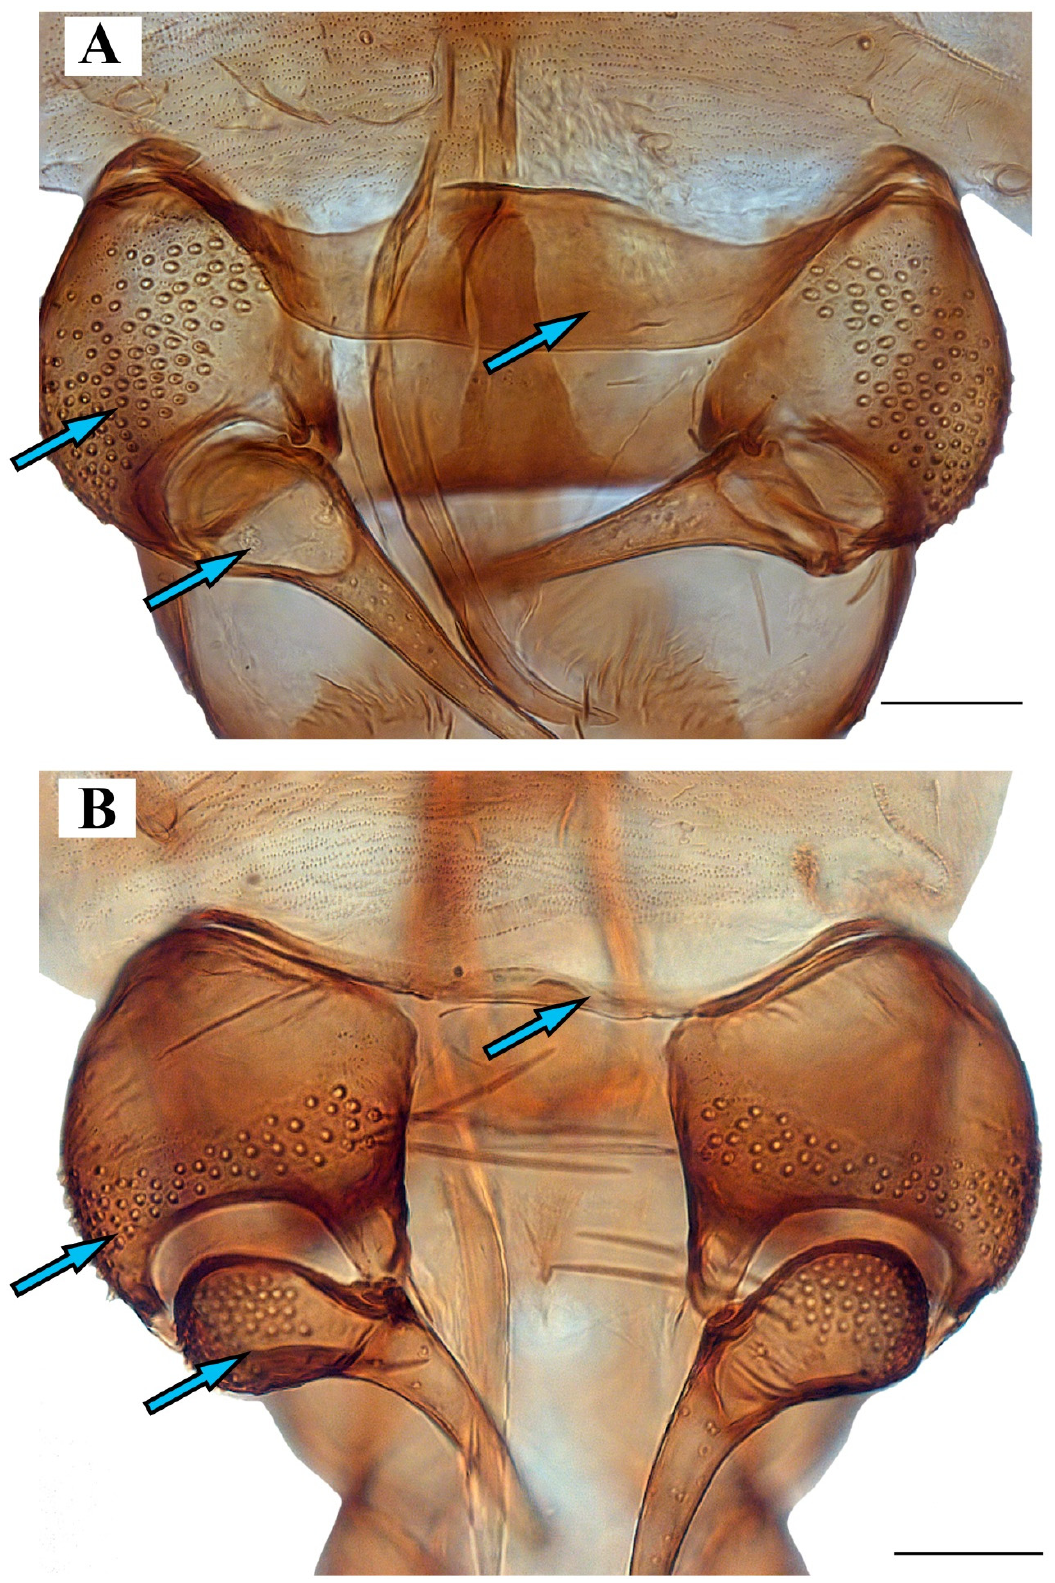
Figure 10. Genitalia of: ( A ) Lepiseodina latipennis (Sarà, 1953), ( B ) Lepiseodina tristis (Meigen, 1830). Blue arrows show differences in hypandrium, gonocoxite, and gonostyli. Scale ( A , B ) in millimeters (mm), scale lines = 0.10 mm.